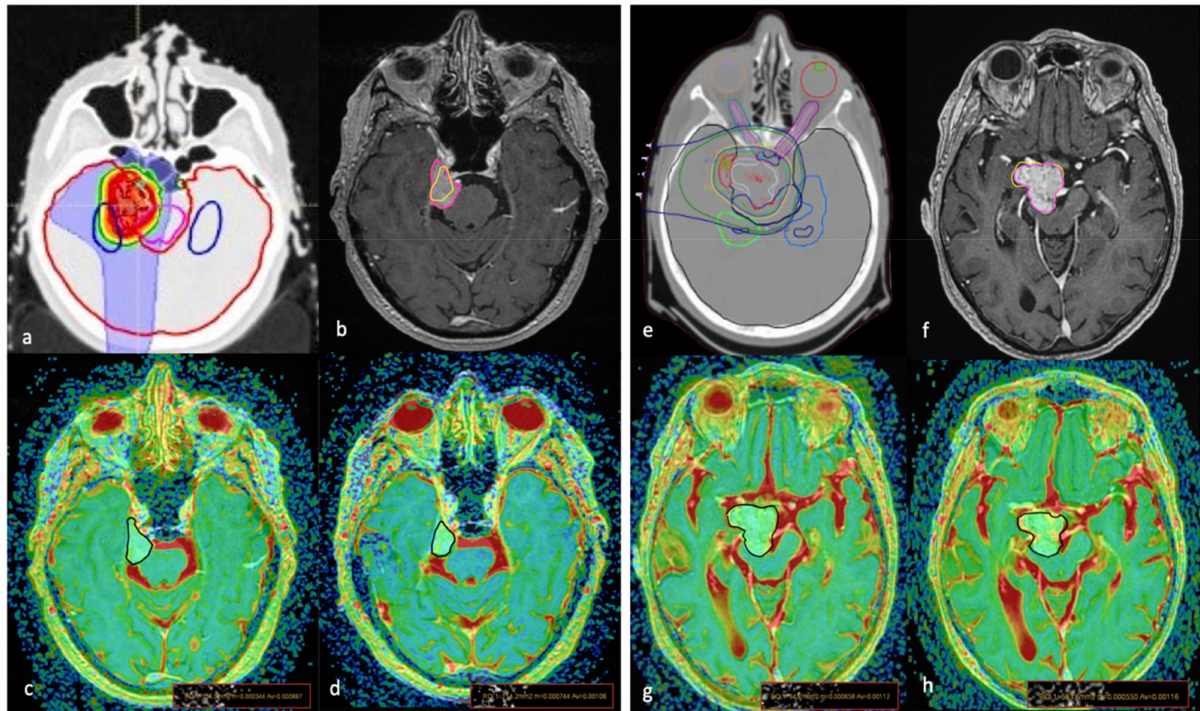
Figure 1. The proton therapy (PT) simulation planning computed tomography scan for target volume and organ at risk delineation ( a , e ); graphic representation of tumour volume variation (VV) on axial MRI T1-weighted + c images of two cases ( a – h ) treated with PT; areas inside the pink lines ( b , f ) represent the pre-treatment contour while areas inside the yellow lines represent the post-treatment (21 months) contour showing a reduction in ( b ) (VV = − 46.9%) and mild increase in ( f ) (VV = +3.40%). The ROI placement on the co-registered T1w + c/ADC maps images, obtained before ( c , g ) and 24 months after ( d , h ) treatment, show lower pre-treatment values ( c ) in the first patient, with a significant increase after PT, while in the second patient had higher pre-treatment ADC values that did not change significantly during the follow-up exam.